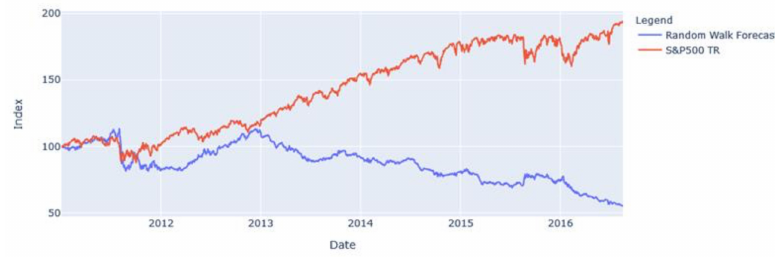
Figure 12. Comparison of the random forest classifier with the random walk model.